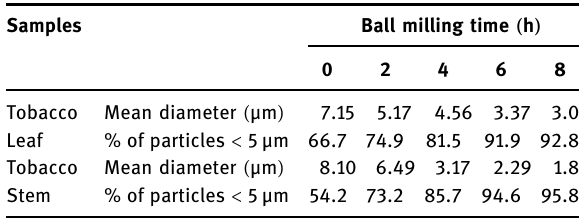
Table 1: Particle size analysis of plant cell wall samples after 0,